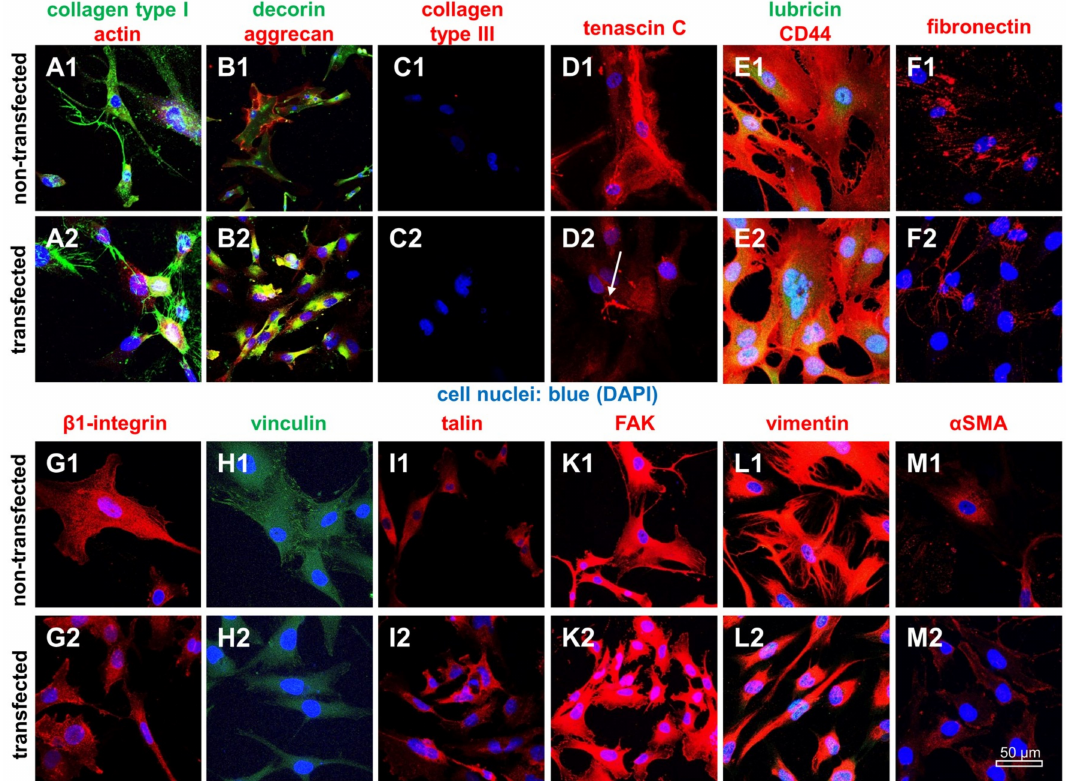
Figure 6. Expression profile of ligament ECM components and of cytoskeletal constituents in 2D cultured non-transfected and SV40 transfected ACL ligamentocytes. Collagen type I (green), actin (red) ( A ); decorin (green), aggrecan (red) ( B ); collagen type III (red) ( C ); tenascin C (red) ( D ); lubricin (green), CD44 (red) ( E ); fibronectin (red) ( F ); β 1 integrin (red) ( G ); vinculin (green) ( H ); talin (red) ( I ); focal adhesion kinase (FAK) (red) ( K ); vimentin (red) ( L ); and α -smooth muscle actin ( α SMA) (red) ( M ). Arrow: Extracellular deposition of tenascin C. ( A1 – M1 ) Non-transfected. ( A2 – M2 ) Transfected ligamentocytes. Cell nuclei were counterstained using 4 (cid:48) ,6 (cid:48) -diamidino-2-phenylindol (DAPI, blue). Scale bars: 50 µ